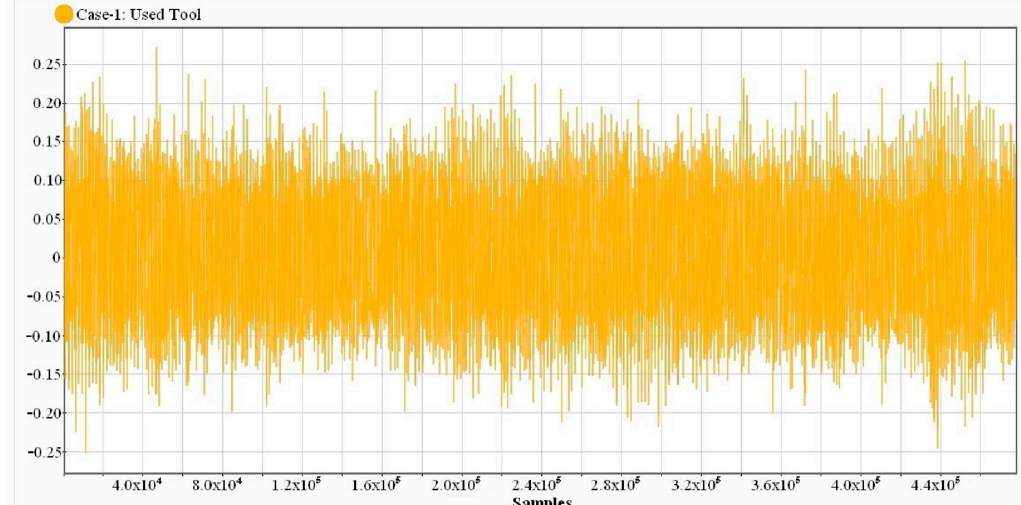
Figure 13. Plot of raw AE signal of 10 s duration for used carbide tool on aluminum work-piece (Case-1).